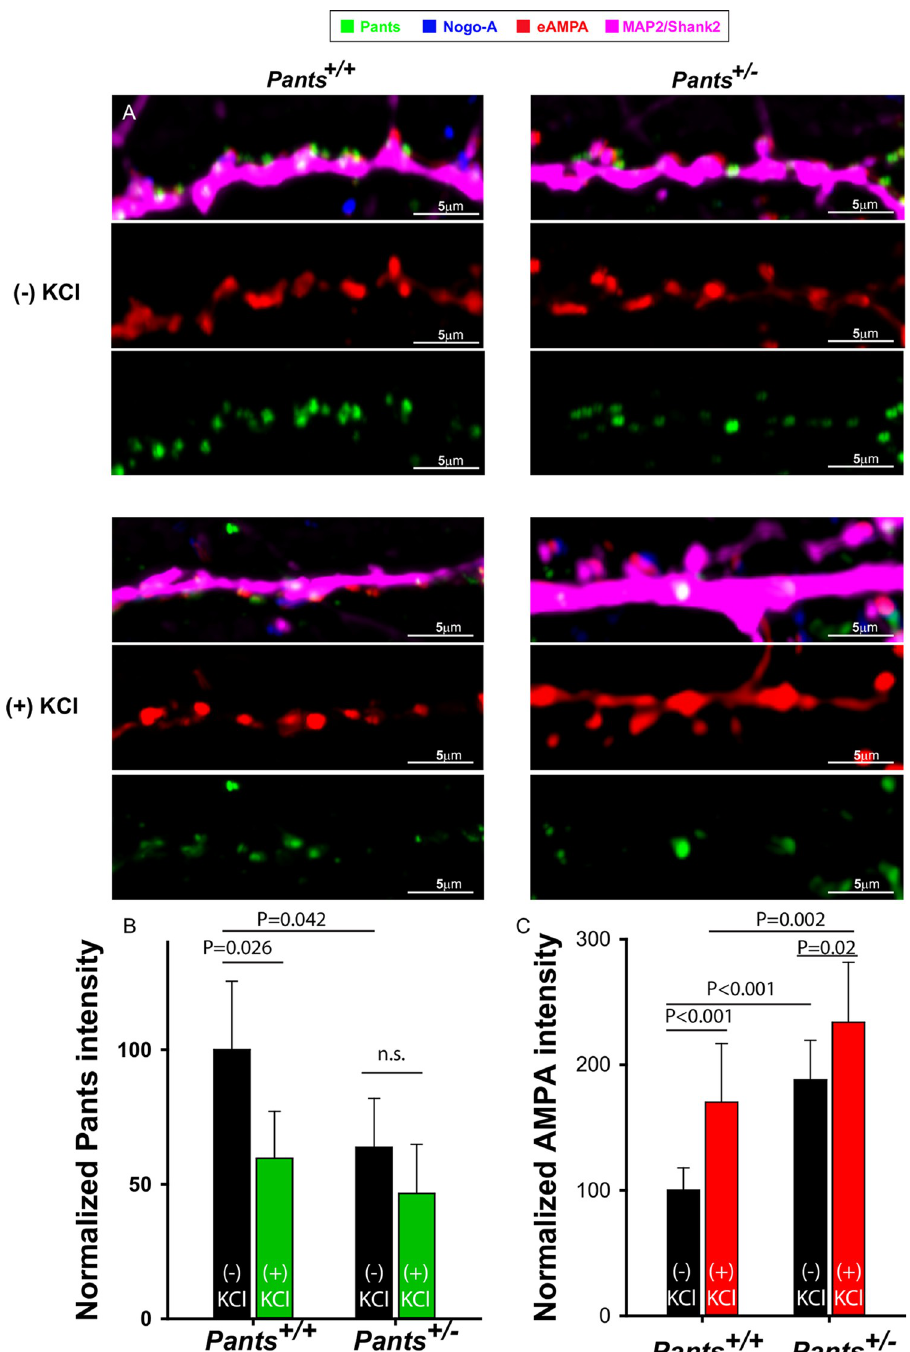
Fig 7. AMPA receptor clustering at spines increases in Pants +/- neurons. A) Representative dendrites from Pants +/ + (left) or Pants +/- (right) hippocampal neurons stained with Nogo-A, an antibody to the extracellular domain of the GluR1 AMPA receptor, and a Nogo-A antibody. Staining was performed in the absence (top) or presence (bottom) of KCl stimulation. B) Quantification of Pants fluorescence intensity in neuronal processes C) Quantification of AMPA clustering at Nogo-A-associated spines in Pants +/+ and Pants -/- neurons in the presence or absence of KCl stimulation. N = 3 samples/ 30 ROIs, Mann-Whitney.